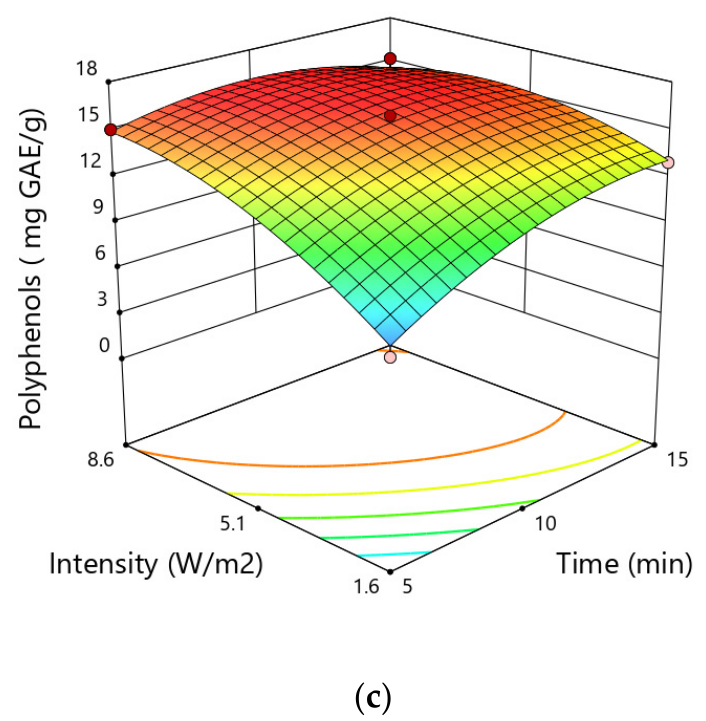
Figure 2. Response surfaces for the total polyphenol content (mg GAE · g − 1 ) in hemp showing the effect of ( a ) particle size and time, ( b ) particle size and intensity, ( c ) intensity and time. In the aerial parts of the cannabis studied by Drini’c [45], the TPC value ranged from 5.85 to 17.05 mg GAE · g − 1 d.w. depending on the solvent concentration (30–90%), and the maturity of the plant. The (50%) ethanol was recognized as the best solvent for the extraction of polyphenols from both young and mature cannabis samples. In the extracts obtained with 50% ethanol, the highest content of TPC was found for both young (17.05 mg GAE · g − 1 d.w.) and mature (9.25 mg GAE · g − 1 d.w.) plants. On the other hand, TPC in flowers alone ranges from 4.7 to 8.1 mg GAE · g − 1 [46]. The results of ANOVA analysis showed that the linear and quadratic terms of particle size and time and intensity of ultrasonic treatment significantly affected the yield of total phenolic content. However, the quadratic terms of all variables had negative coefficients, which indicates the existence of a local extreme in the studied area. This extreme is very clearly visible in the case of particle size where the value of TPC initially increases with the increase of particle size and then decreases. Based on the values of the probabilities listed in Table 1, it can also be concluded that particle size was the variable that had the greatest impact on the extraction efficiency of polyphenols from hemp. The highest content of polyphenols of 15.89 mg GAE · g − 1 was obtained during the extraction with the particles of 0.75 mm at a time of 10 min and ultrasound intensity of 5.1 W · cm − 2 , while the lowest value was noticed at 6.69 mg GAE · g − 1 for the particle size of 1.25 mm at time of 10 min and ultrasound intensity of 1.6 W · cm − 2